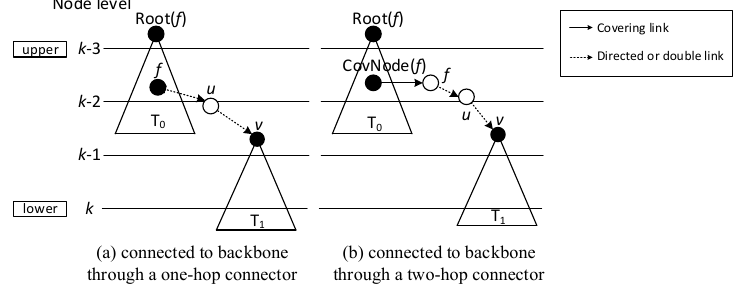
Figure 16. Connecting T (cid:2869) to T (cid:2868) using one-hop and two-hop connectors.